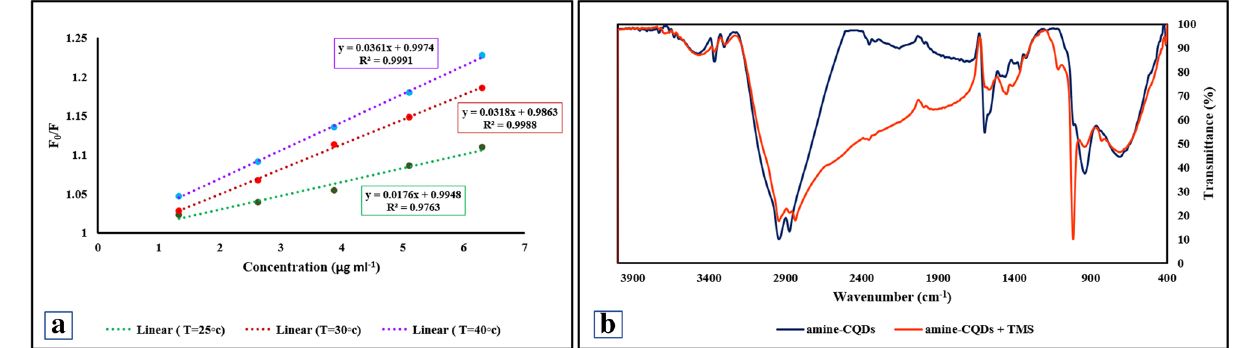
Figure 3. ( a ) The Stern–Volmer curves of TMS at the temperatures of 25 °C, 30 °C, and 40 °C, ( b ) FT-IR of amine-CQDs (navy color), and amine-CQDs with TMS (red color).